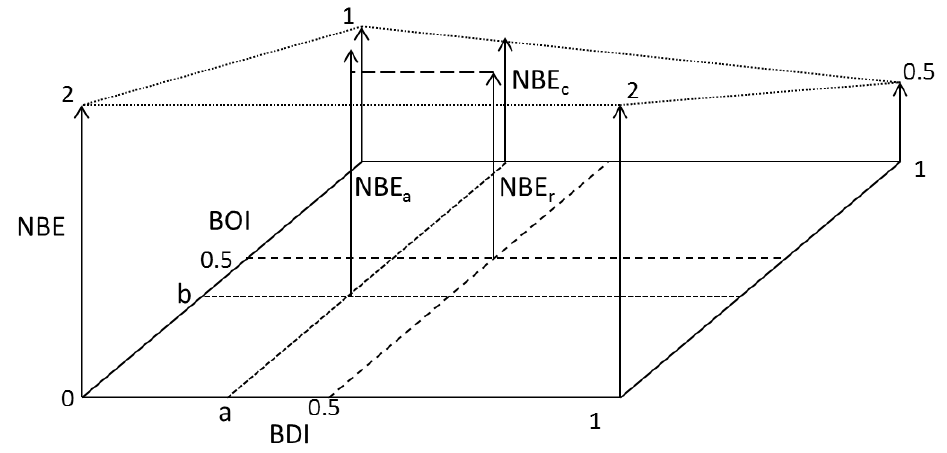
Figure 6. Determining BOI from EUI